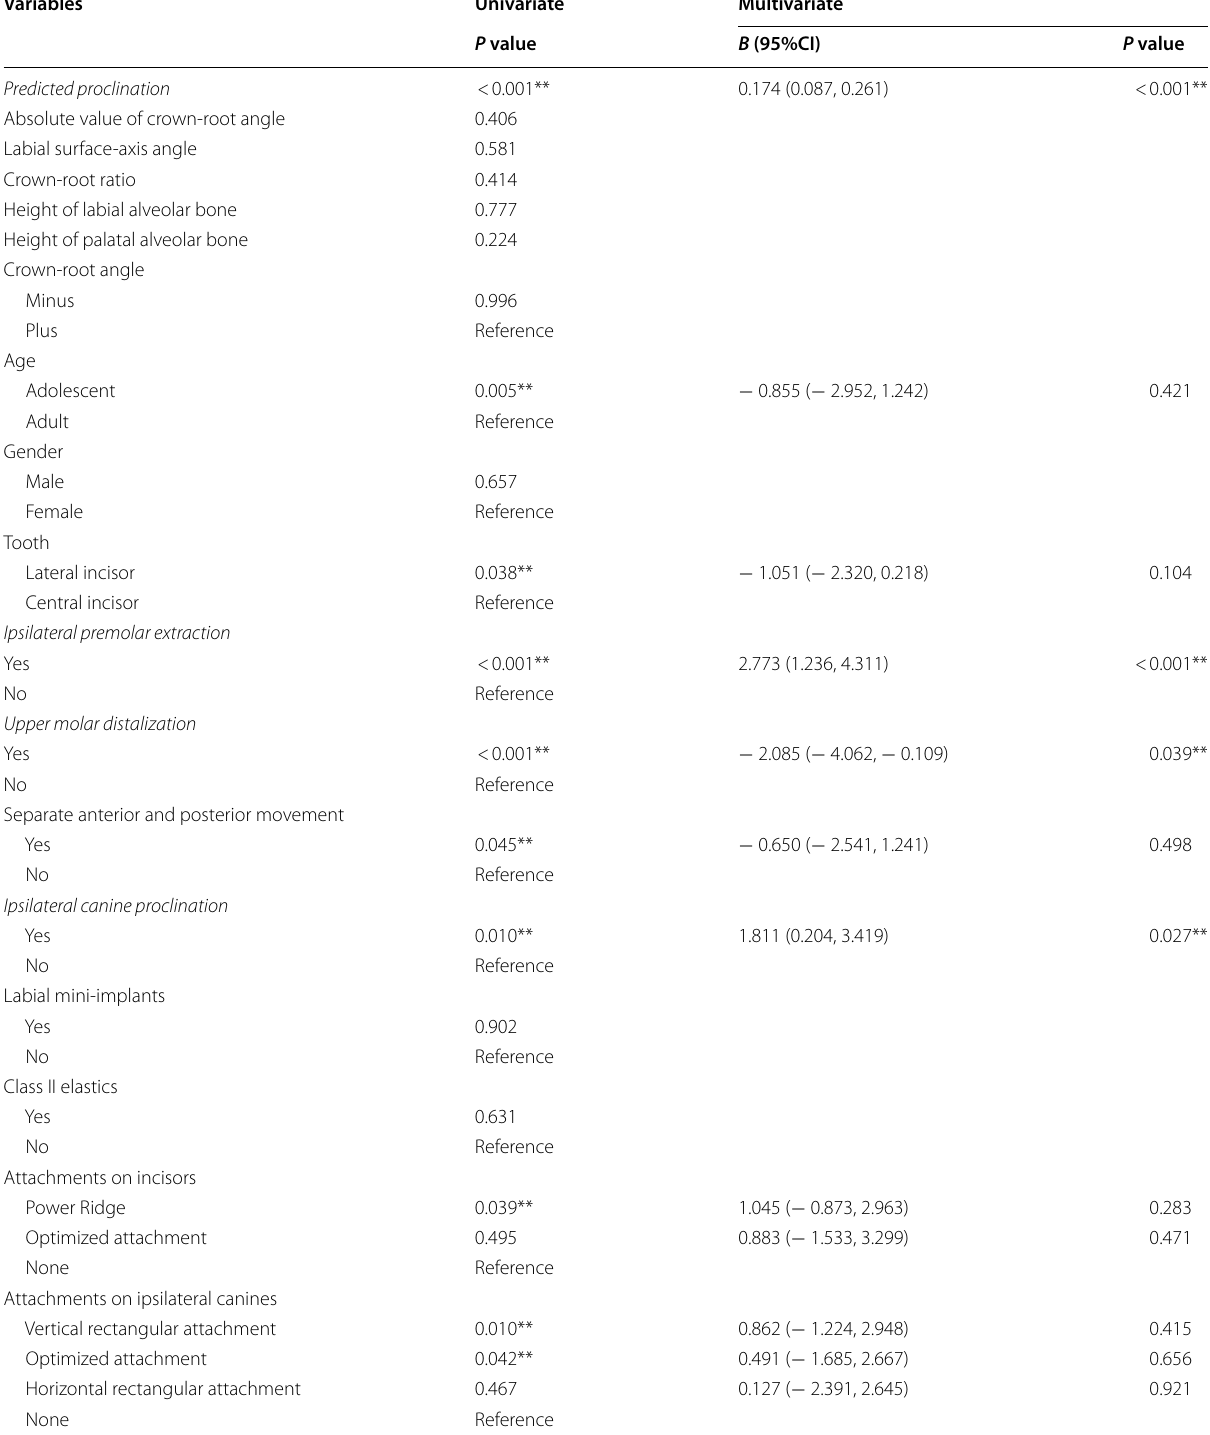
Table 5 Univariate and multivariate linear regression analyses for DPA of upper incisor